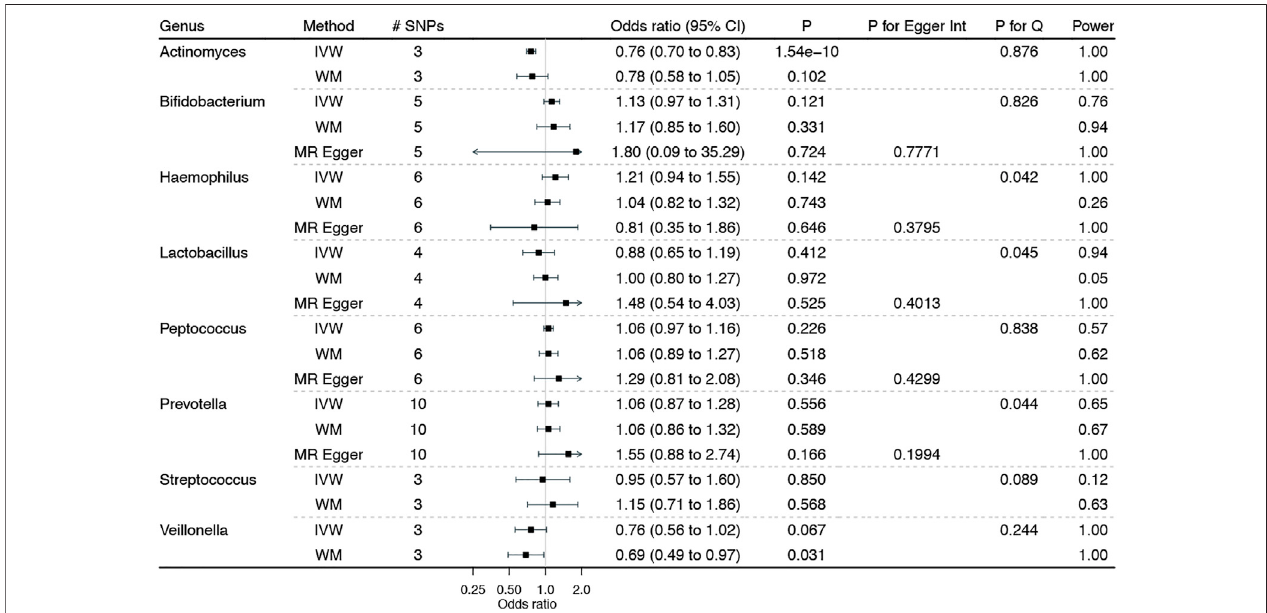
FIGURE 3 | Associations of genetically predicted esophagus-speci fi c genera of gut microbiota on Barrett ’ s esophagus. IVW: inverse variance weighted method withmultiplicative random-effects; WM:weighted median estimator. Notably, thecorrespondingestimates fromMR-Eggerregressionfor Actinomyces , Streptococcus , and Veillonella were not showed herein due to the wide con fi dence